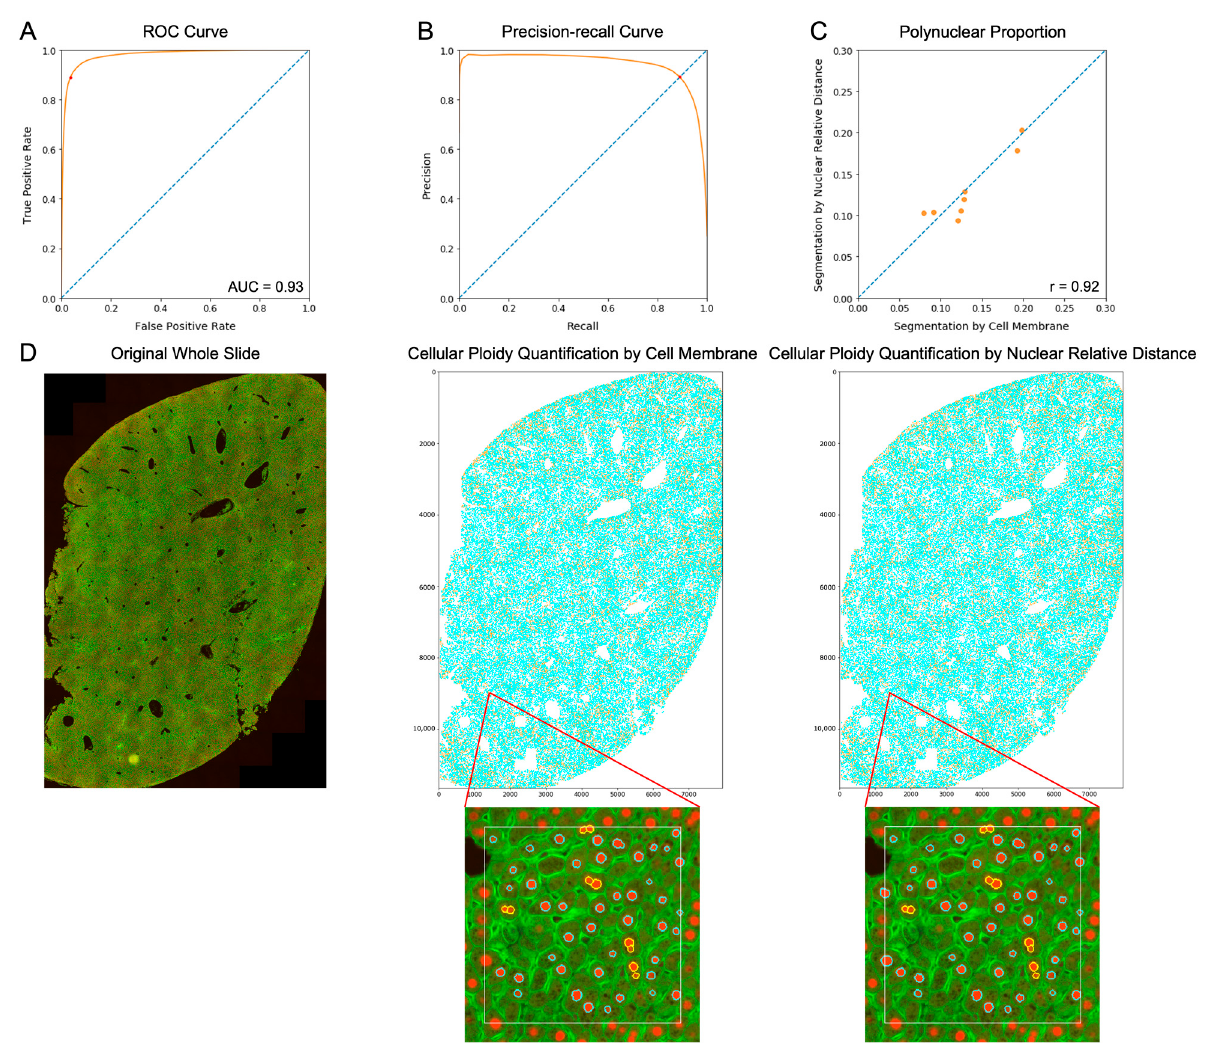
Figure 4. Evaluation of the accuracy of cellular ploidy determined by nuclear relative distance. ( A ) The ROC curve of cellular ploidy determined by nuclear relative distance with an AUC of 0.93. The ground truth is the cellular ploidy quanti fi cation using cell membrane information. The selected 𝑡ℎ𝑟𝑒𝑠ℎ𝑜𝑙𝑑 (cid:3010)(cid:3007) (5.5 pixels) is denoted by the red dot. ( B ) The precision-recall curve of cellular ploidy determined by nuclear relative distance. The selected 𝑡ℎ𝑟𝑒𝑠ℎ𝑜𝑙𝑑 (cid:3010)(cid:3007) (5.5 pixels) is denoted by the red dot. ( C ) The sca tt er plot demonstrates the high correlation of polynuclear proportion between cell membrane segmentation and nuclear relative distance segmentation. ( D ) The distribution maps of mononuclear cells and polynuclear cells determined by cell membrane or nuclear relative distance. Cyan dots correspond to mononuclear cells, and yellow dots correspond to polynuclear cells. The detailed cellular ploidy quanti fi cation result of a small region (300 × 300 pixels) is shown below the distribution map, where nuclei within mononuclear cells are marked in cyan, and nuclei within polynuclear cells are marked in yellow.